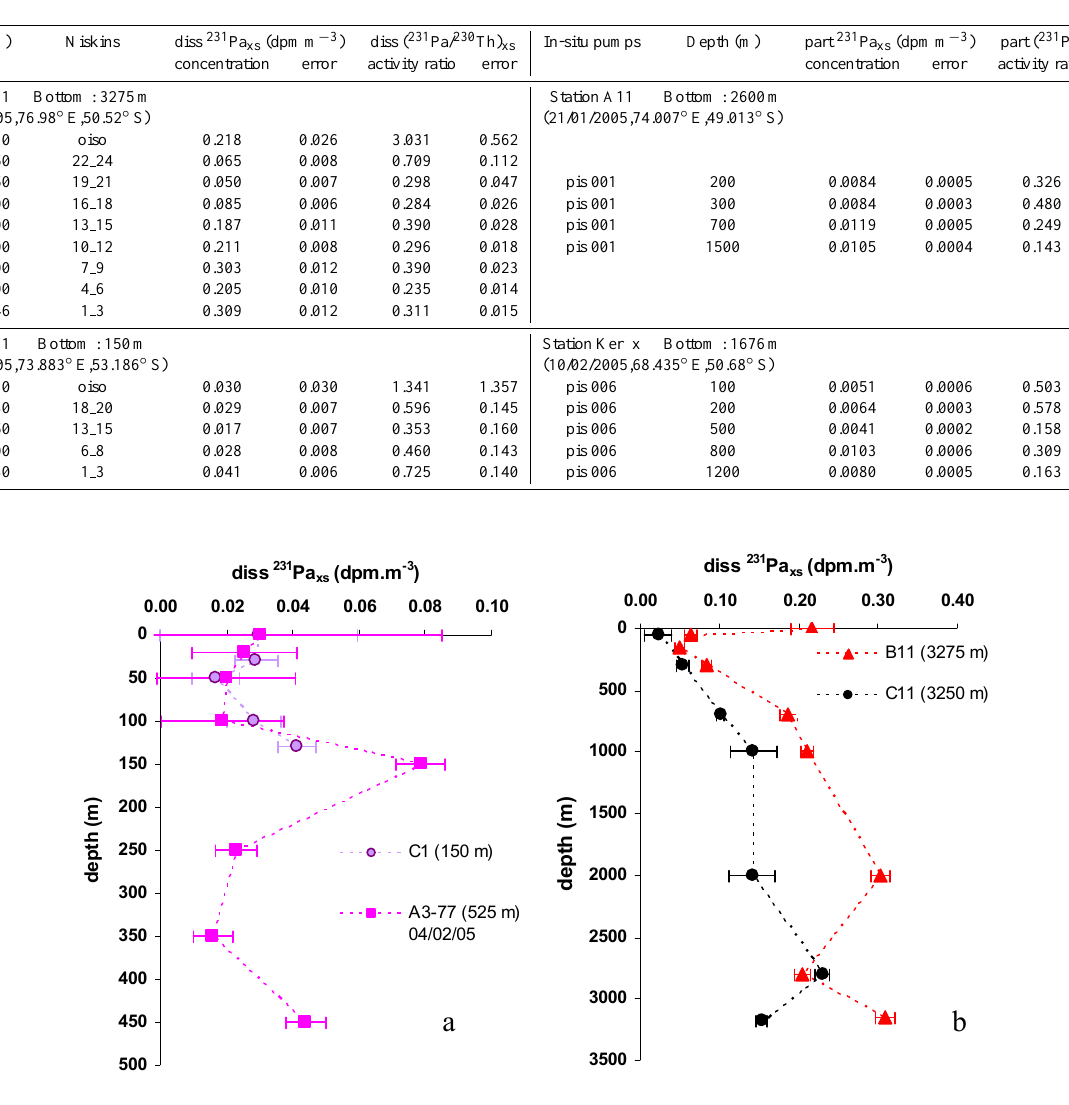
Table 4. Kerguelen on and off plateau stations: dissolved (left) and particulate (right) 231 Pa xs concentrations in dpmm − 3 and corresponding 231 Pa 230 Th 230 Th and 231 Pa lithogenic contributions, please refer to Sect. 3 of the present text respectively. Errors xs / xs activity ratios. For (2 σ) are further described in Sect.